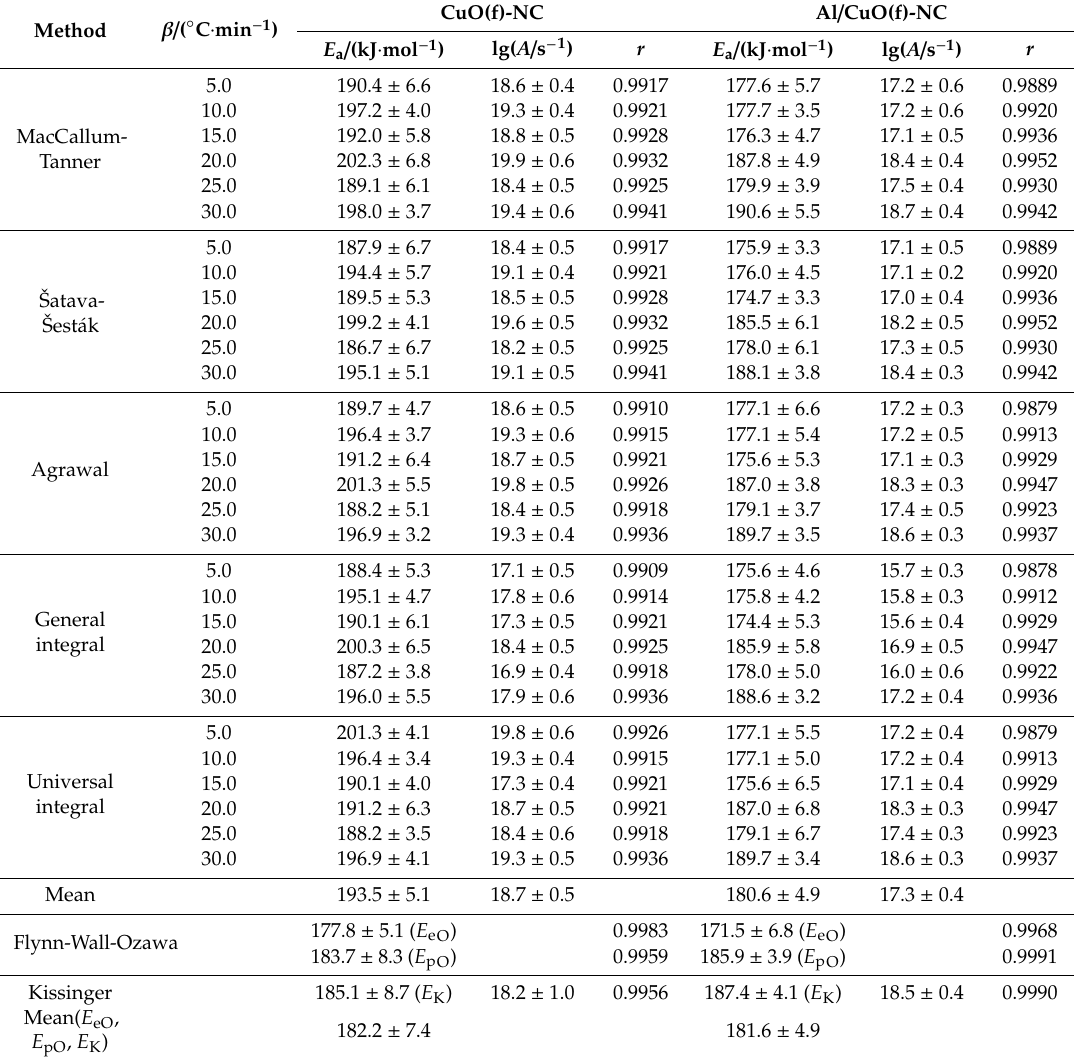
Table 2. Calculated values of kinetic parameters of decomposition reaction for flaky-shaped CuO(f)-NC and Al / CuO(f)-NC.